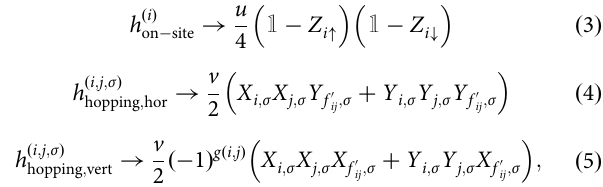
Table 2 Per-time